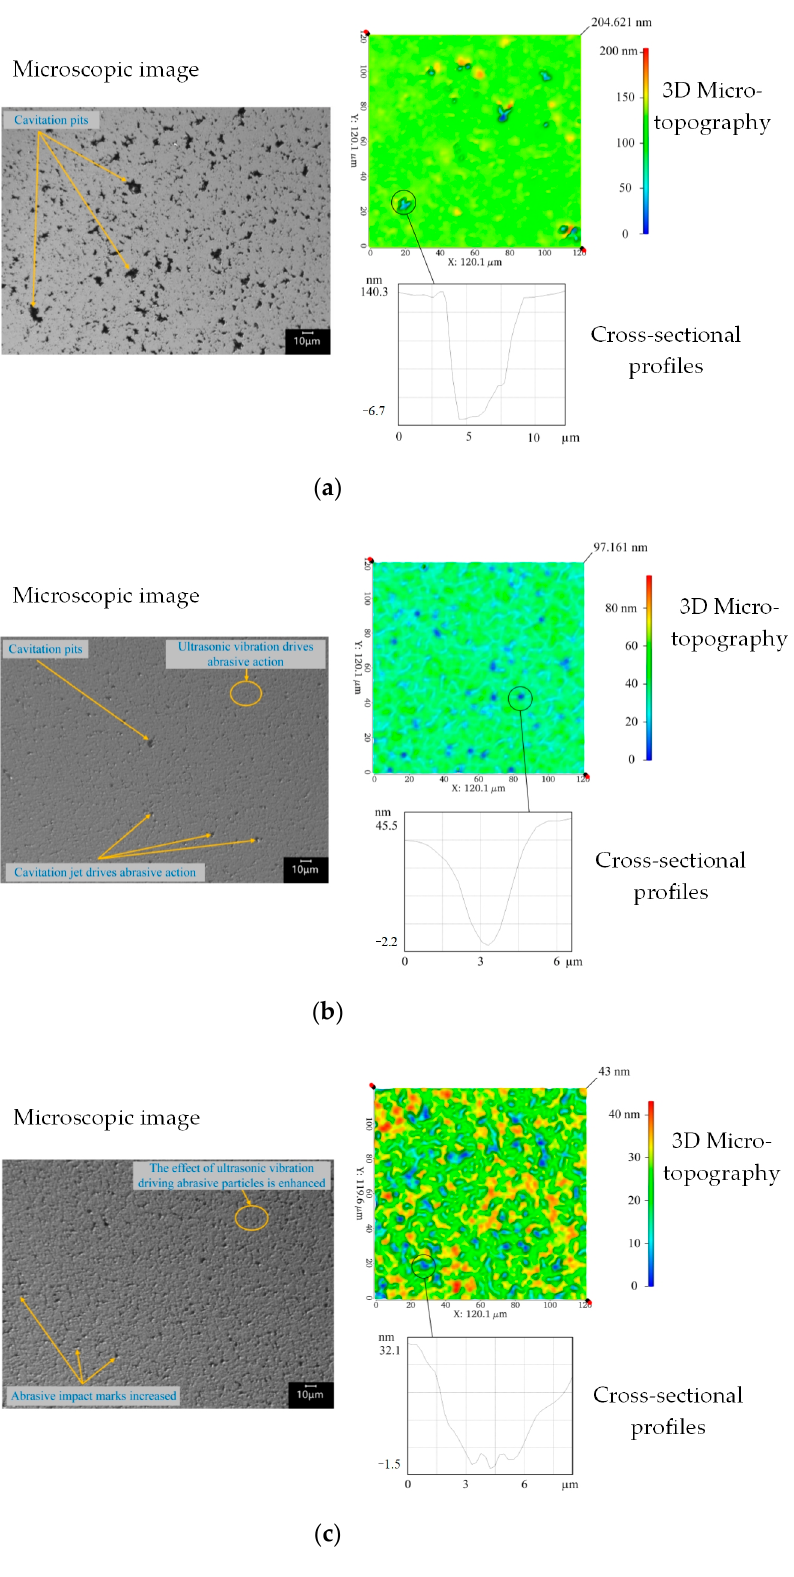
Figure 10. Comparison of machining morphology at different abrasive concentrations at a current of 0.7 A. ( a ) Abrasive particle concentration was 0%. ( b ) Abrasive particle concentration was 5%. ( c ) Abrasive particle concentration was 15%.